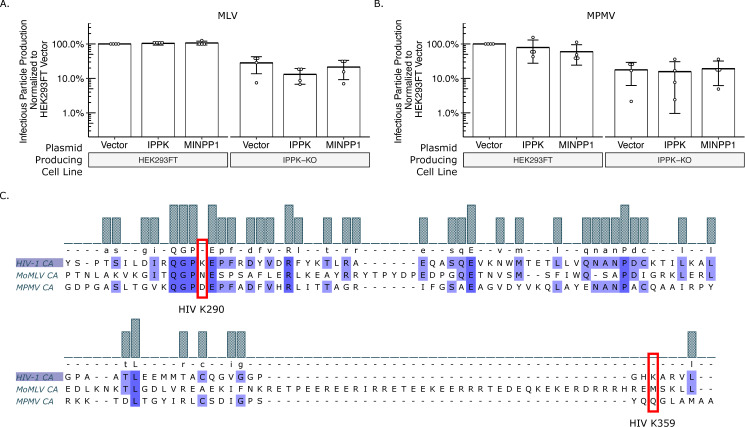
Gammaretroviruses and Betaretroviruses do not require IP6 or IP5 as assembly co-factors.Bar charts of percent infectious particle release of other retroviral genera normalized to virus from HEK293FT cells expressing the empty vector. (A) The Gammaretrovirus Murine leukemia virus (MLV, n = 4). (B) The Betaretrovirus Mason-Pfizer monkey virus (MPMV, n = 5). (C) Multiple sequence alignment of CA proteins of HIV-1, MLV, and MPMV. Note the lack of K290 and K359 homology in MLV and MPMV.